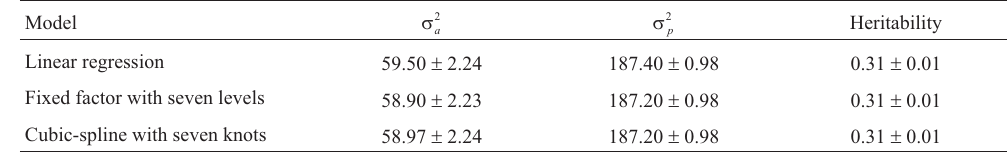
Table 6 - Estimates of variance components (kg/100) 2 and heritability for the three